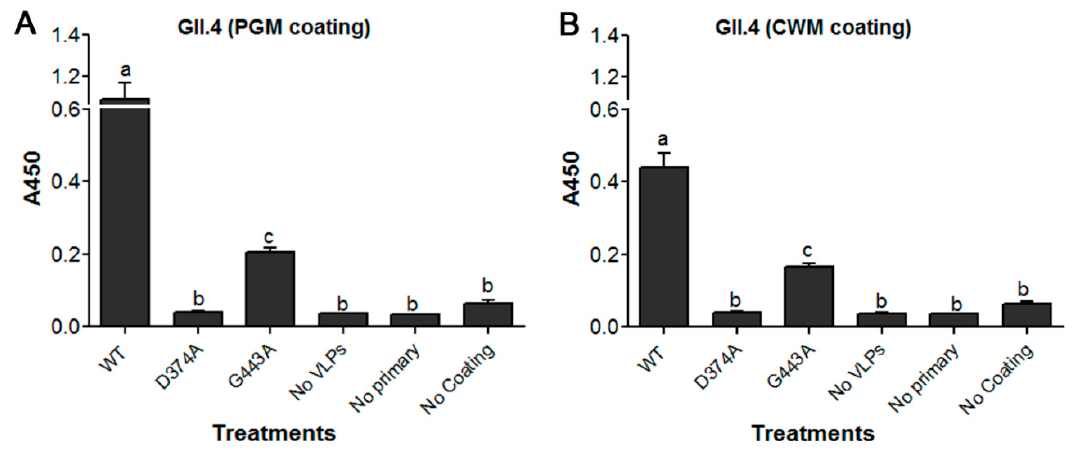
Figure 3. ELISA showing the binding of HuNoV GII.4 WT VLPs and its two mutants D374A and G443A VLPs to ( A ) PGM and to ( B ) lettuce CWM. Means with different letters differ significantly.